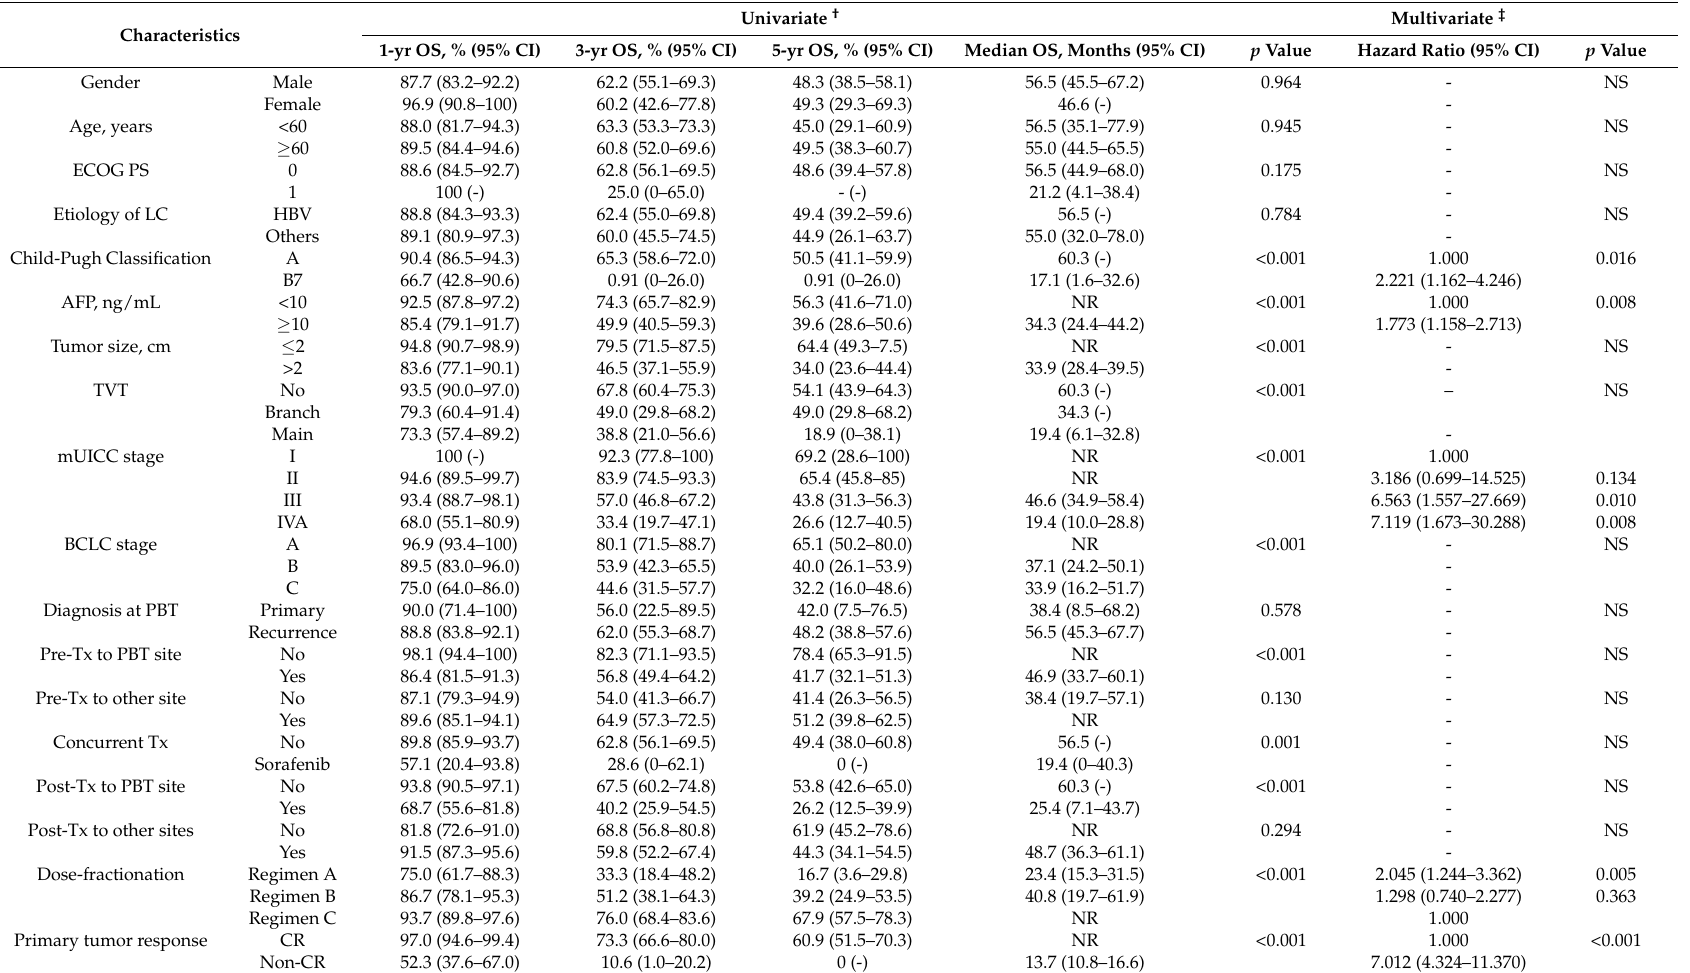
Table 3. Univariate and multivariate analysis of factors associated with overall survival